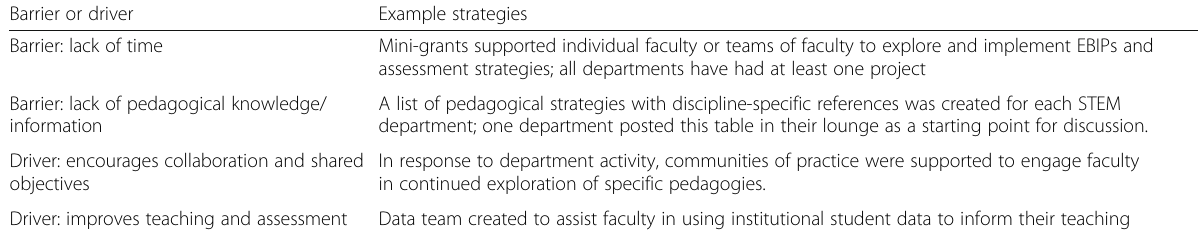
Table 4 Example strategies informed by barrier and driver categories Barrier or driver Example